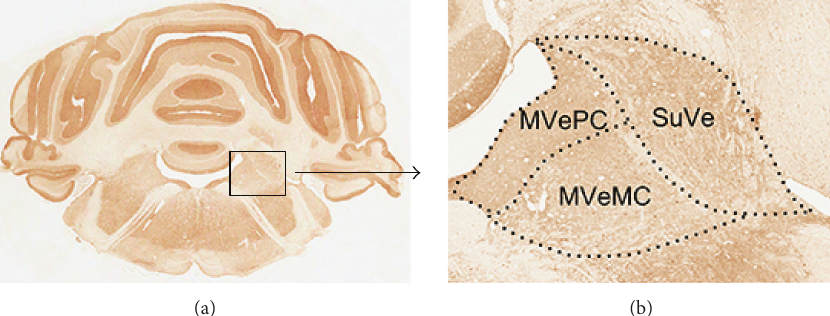
Figure 6: Diagram of regions of interest (SuVe, MVePC, and MVeMC) in the rat brain (Bregma − 11.60mm) stained with anti-c-Fos antibody. The box in (a) is enlarged in (b). SuVe: superior vestibular nucleus; MVeMC: magnocellular part of medial vestibular nucleus; MVePC: parvicellular part of medial vestibular